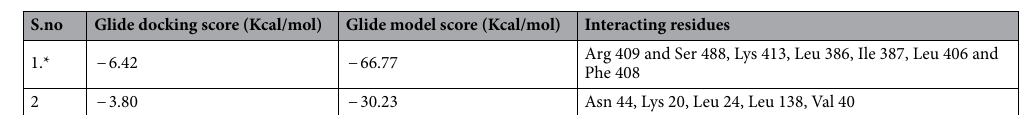
Table 4. Docking results of MiADMSA at two different binding sites. *Figure 11 docked pose.